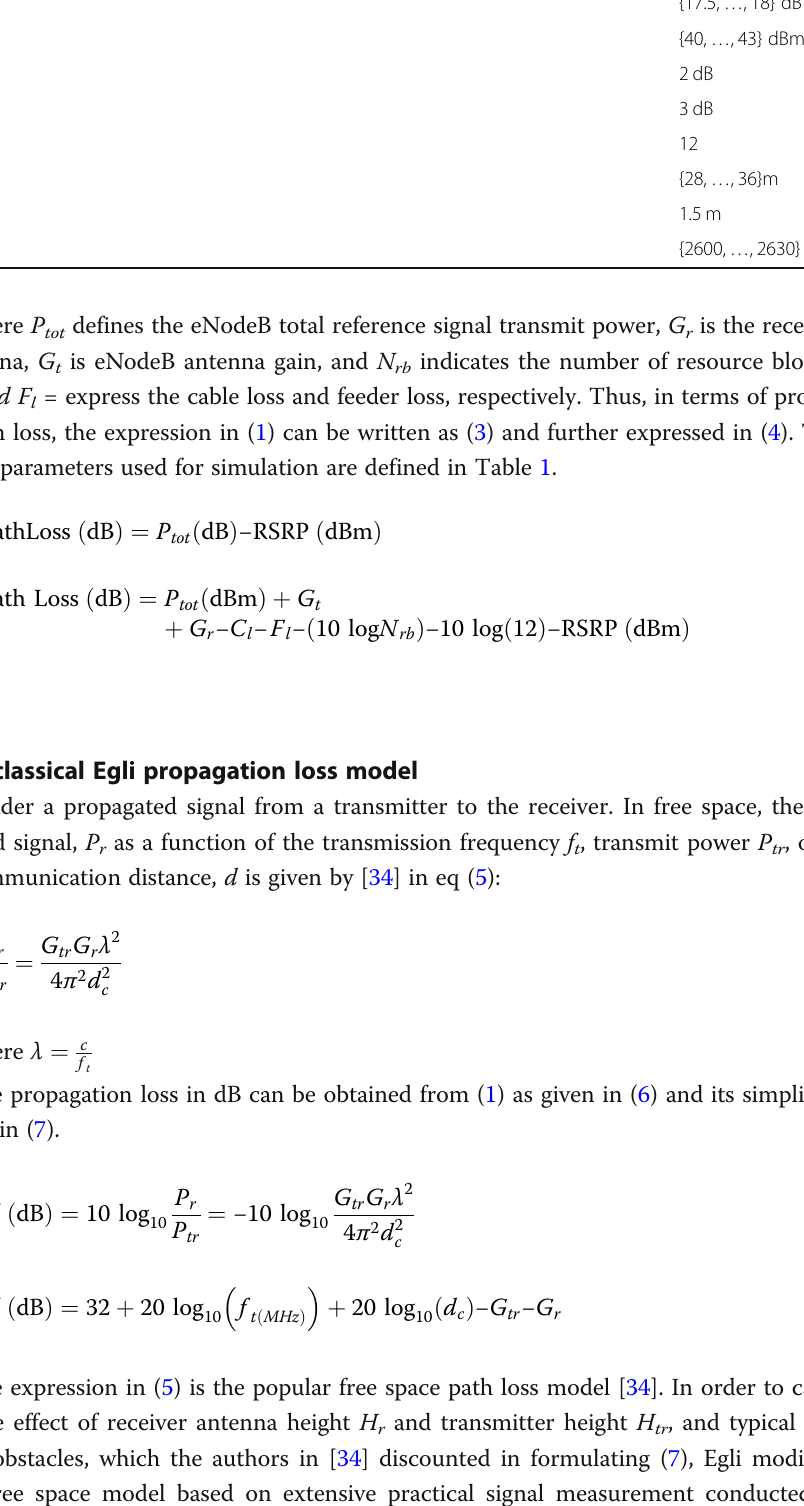
Table 1 Propagation loss computation parameters